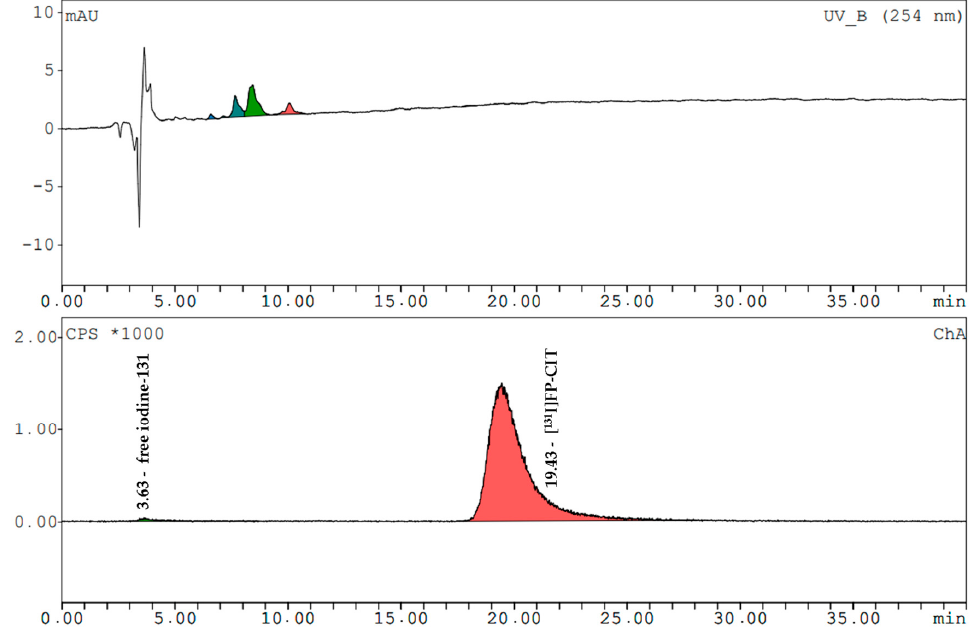
Figure 4. HPLC analysis of a [ 131 I]FP-CIT product solution. Upper trace: UV-VIS spectrum, lower trace: radiometric spectrum.